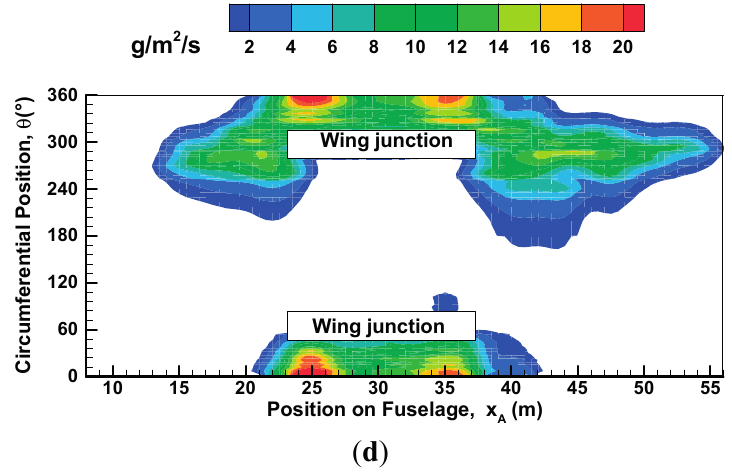
Figure 18. Iso-contours of the mass loss rate over the skin of the composite-type fuselage with a wind direction of 270°. ( a ) Quiescent fire condition; ( b ) low wind speed of 2 m/s;